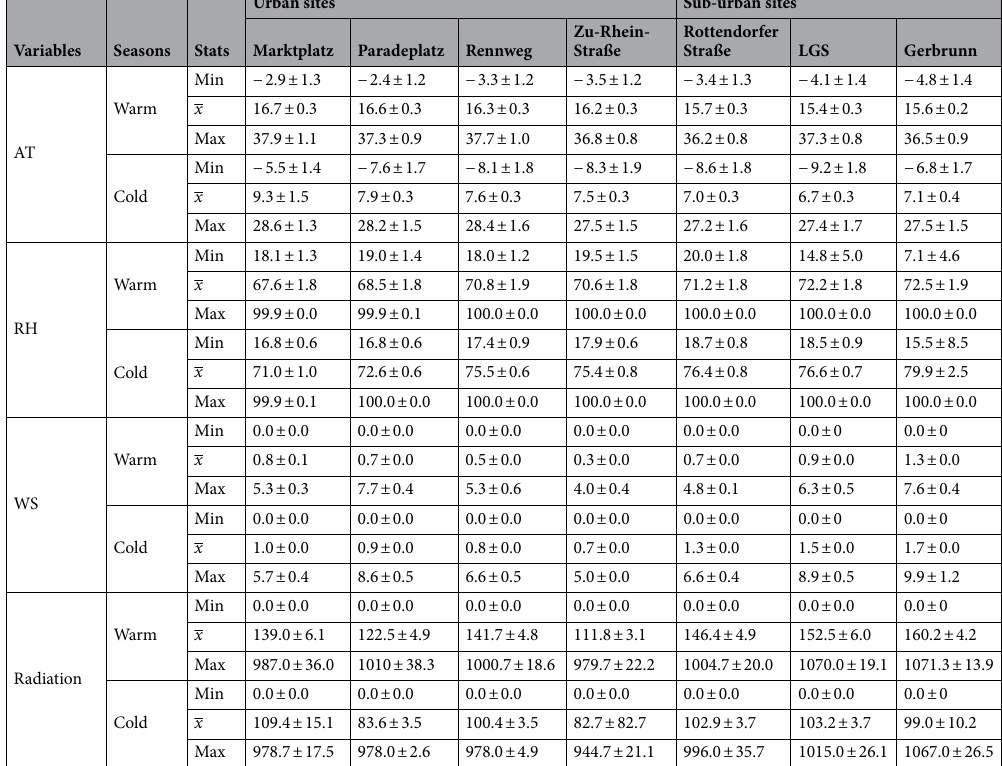
Table 1. Minimum (min), average ( x ) and maximum (max) values of air temperature (AT), relative humidity (RH), wind speed (WS) and global radiation of urban and sub-urban sites over 3 investigated years (± SE of mean values between